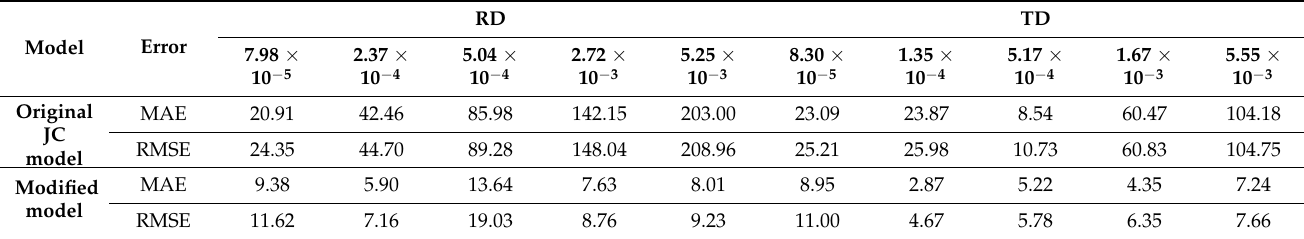
Figure 14. Comparison of predicted tensile curves of JC model and experimental tensile curves at biaxial RD ( a ) and TD ( b ). Table 5. Traditional JC model parameters for biaxially tensile condition. Table 6. Mean absolute error (MAE) and root mean square error (RMSE) between predicted and experimental